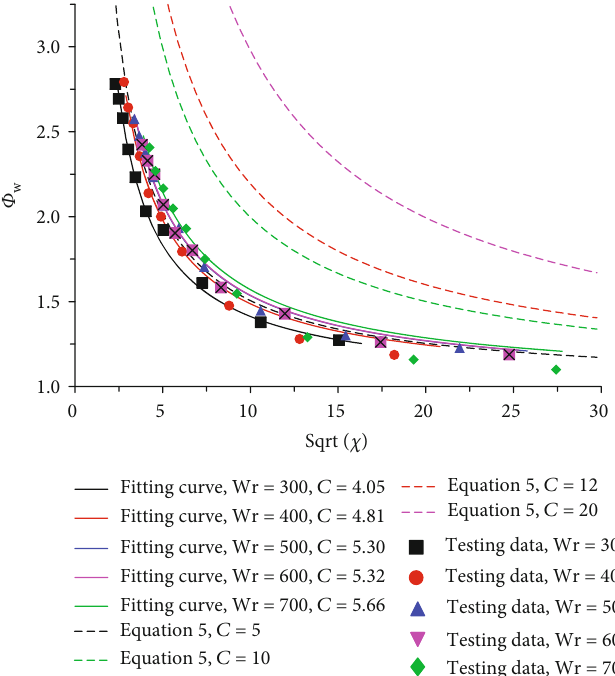
Figure 13: The relationship between Φ